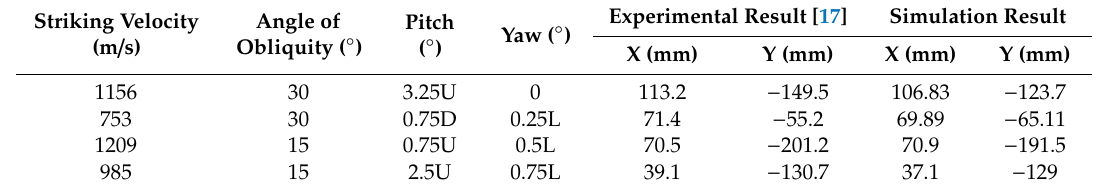
Table 1. Comparison of the positions of tip ends for various conditions.